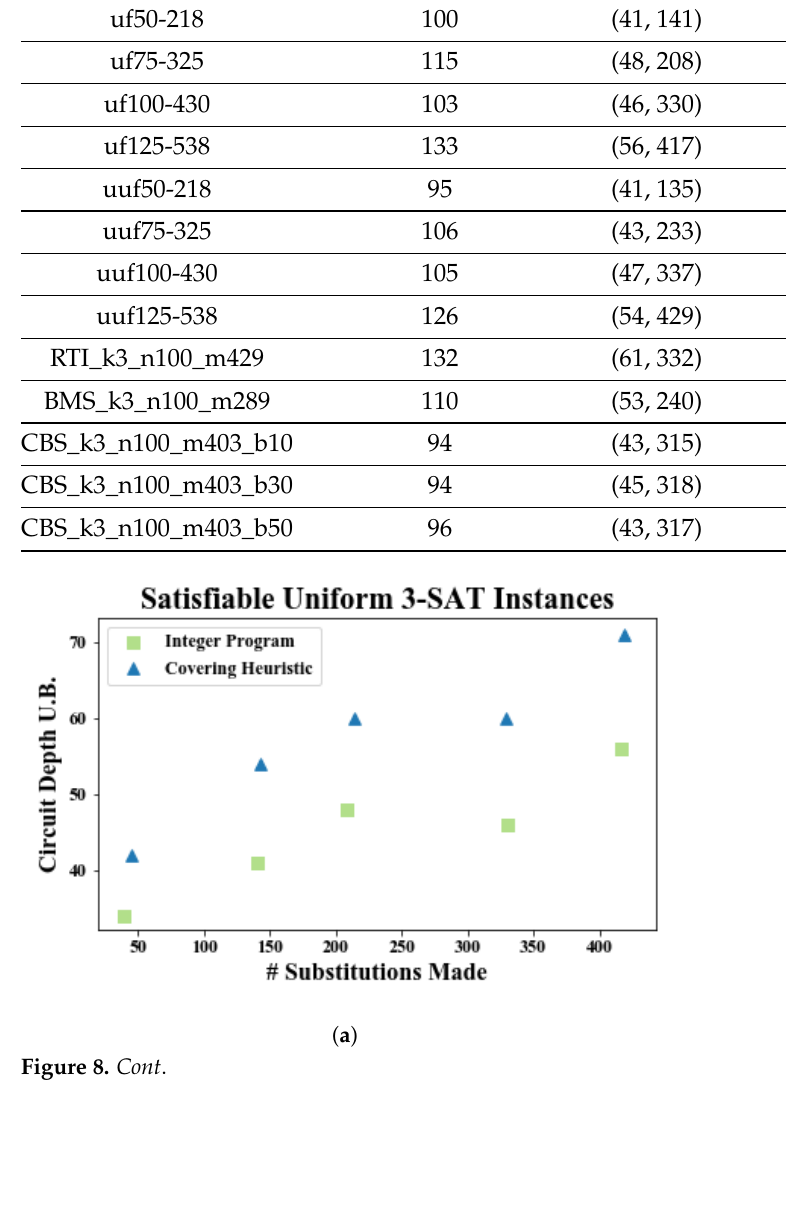
Table 3. The unitary circuit depth upper bound for each SATLIB 3-SAT instance using the linear formulation and product formulation with GVS methods. The IP and Covering Heuristic columns also displays the number of substitutions made to cover every c